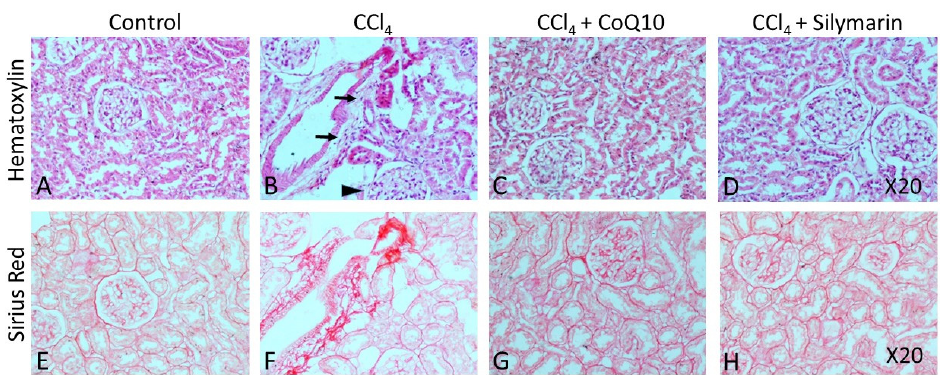
Figure 6. Effect of CCl 4 and supplementation with CoQ10 and silymarin on kidney tissue. Hemtoxylin-eosin staining shows the cellular morphology in control ( A ), CCl 4 ( B ), CCl 4 + CoQ10 ( C ), and CCl 4 + silymarin ( D ) kidney of ovariectomized rats. Arrows indicate infiltrating cells. Arrowhead depicts deformed glomerular structure. Sirius Red staining depicts fibrosis in control ( E ), CCl 4 ( F ), CCl 4 + CoQ10 ( G ), and CCl 4 + silymarin ( H ) kidney of ovariectomized rats. 20× magnification.